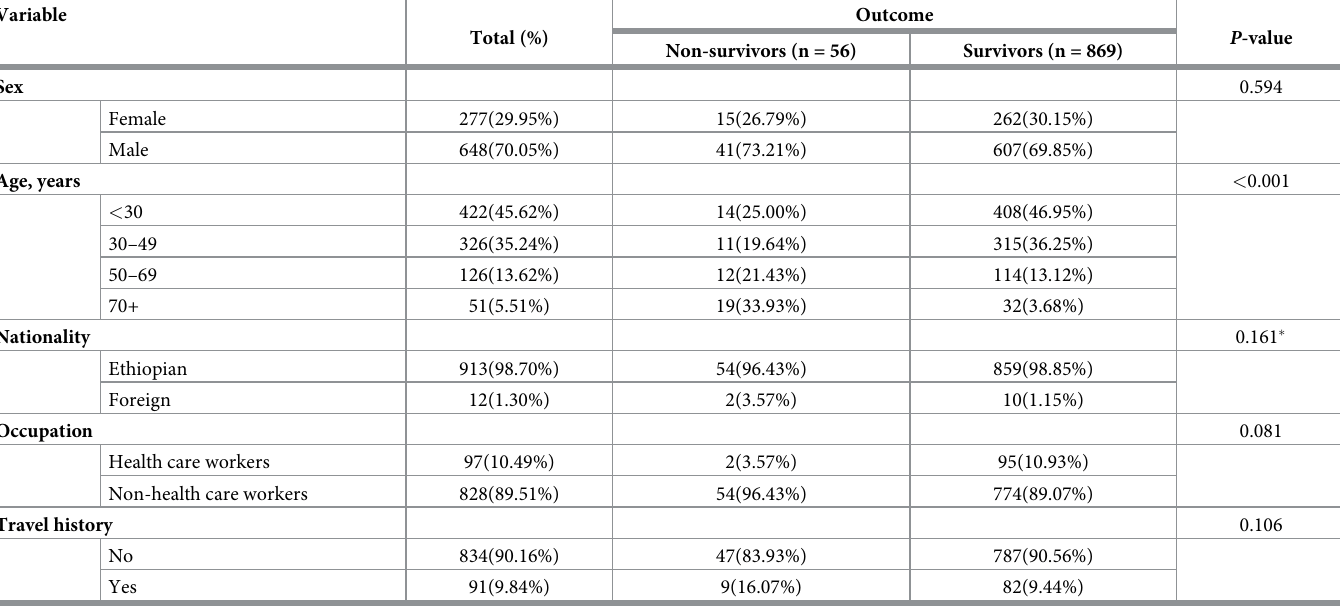
Table 1. Socio-demographic characteristics of 925 hospitalized COVID-19 patients of Tigray, Northern Ethiopia,